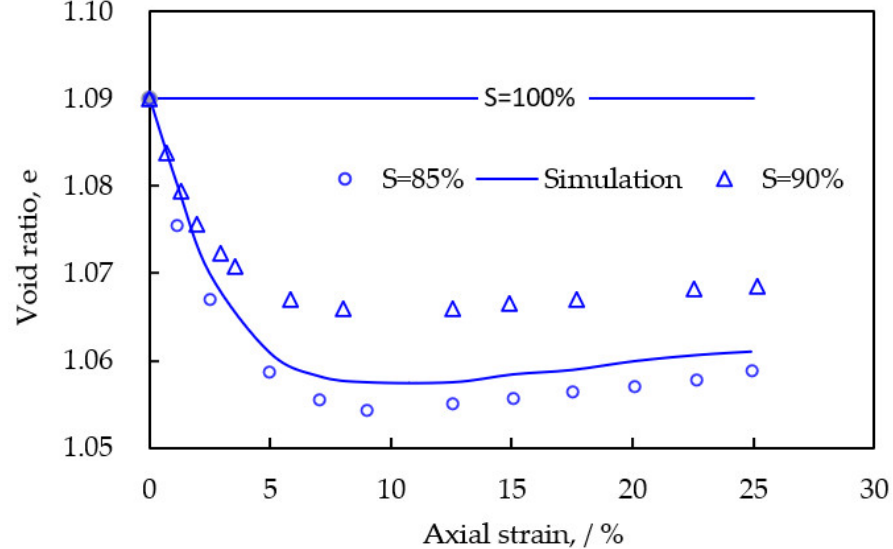
Figure 6. Undrained test results on the void ratio and the axial strain of the gassy sand ( e 0 = 1.09, p c p c = 50 = 50 kPa).